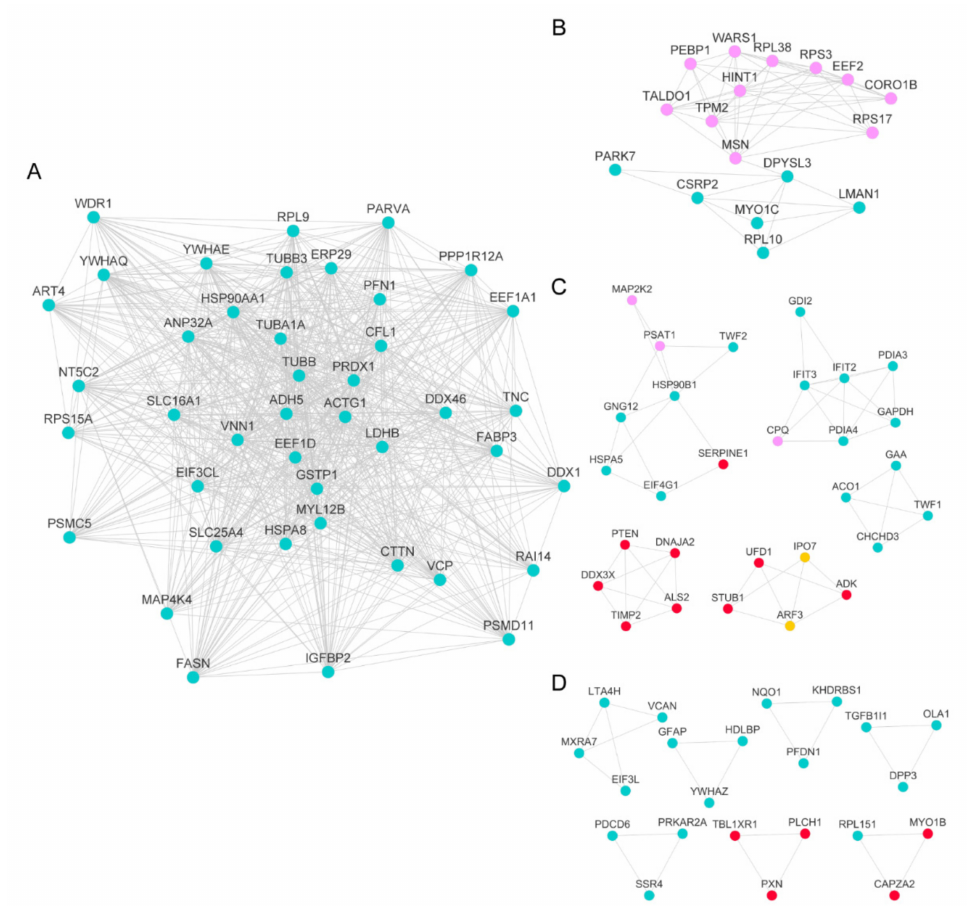
Figure 7. Protein-protein interaction network of the highly correlated modules of proteins from WGCNA. Hub-proteins in the red, pink, and turquoise modules after using the MCODE algorithm of Cytoscape to reduce the nodes for those with more weight in the network from the whole data set. ( A ) Cluster 1 with an MCODE score of 35,220 and 42 nodes. ( B ) Cluster 2 with a score of 7375 and 17 nodes. ( C ) Clusters 3 to 7 with MCODE score >3500. ( D ) Clusters 8 to 14 with MCODE score >3000. Node colors correspond to their original modules, except for IPO7 and ARF3, shown in